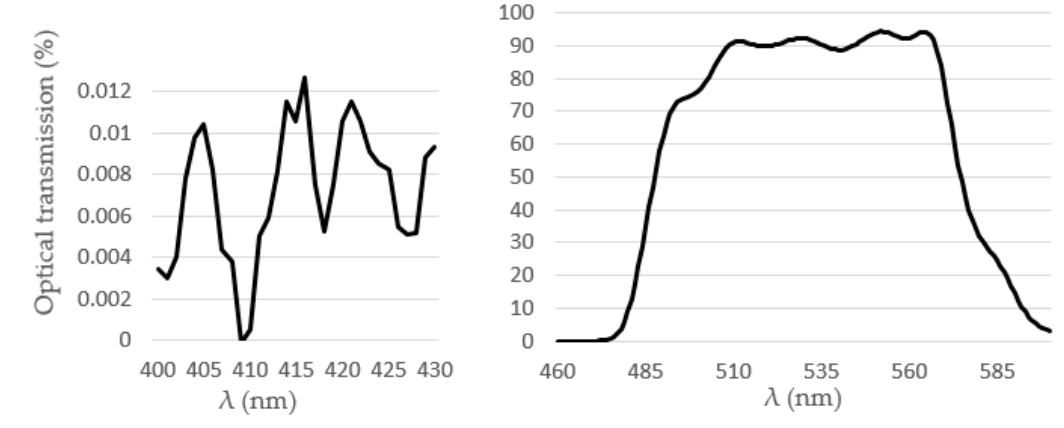
Figure 5. Optical transmittance of the band pass filter.